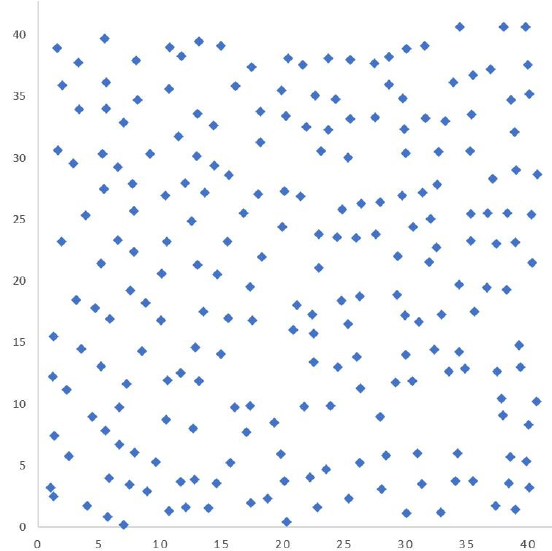
Figure 2. Spatial distribution of fir trees in sample plot. The blue points are the coordinate points representing the relative position of the fir.